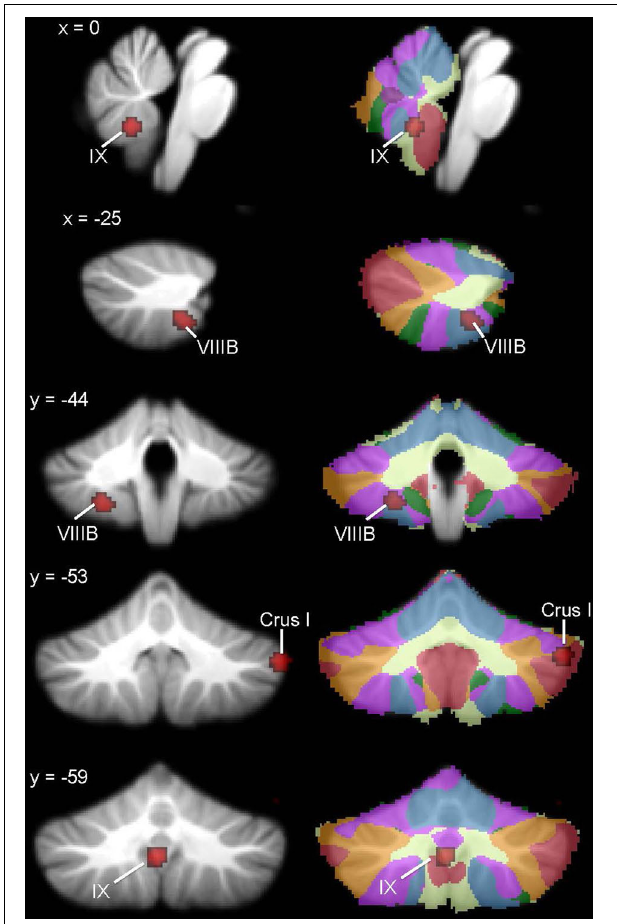
FIGURE 2 | Cerebellar GM differences in ASD. Left , regions in the whole-brain analysis showing significant ALE voxels where ASD < TD (red), thresholded at p < 0 . 001, k > 50. Right , corresponding slices showing functional connectivity maps of the cerebellum (Buckner et al., 2011). Networks are color-coded such that blue, somatomotor; green, dorsal attention; violet, ventral attention; cream, limbic; orange, frontoparietal; red, default